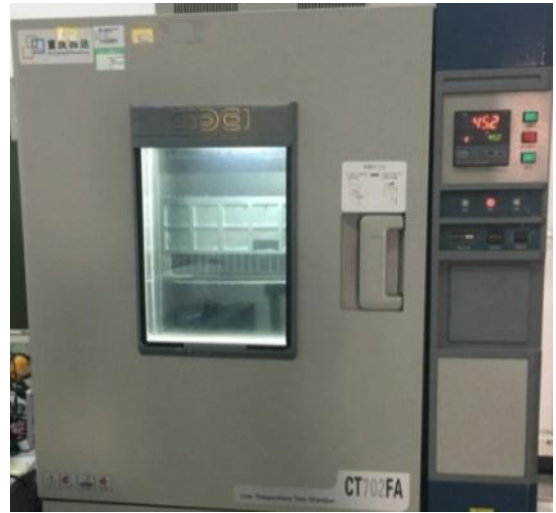
Figure 11. Temperature variation of the pump laser.